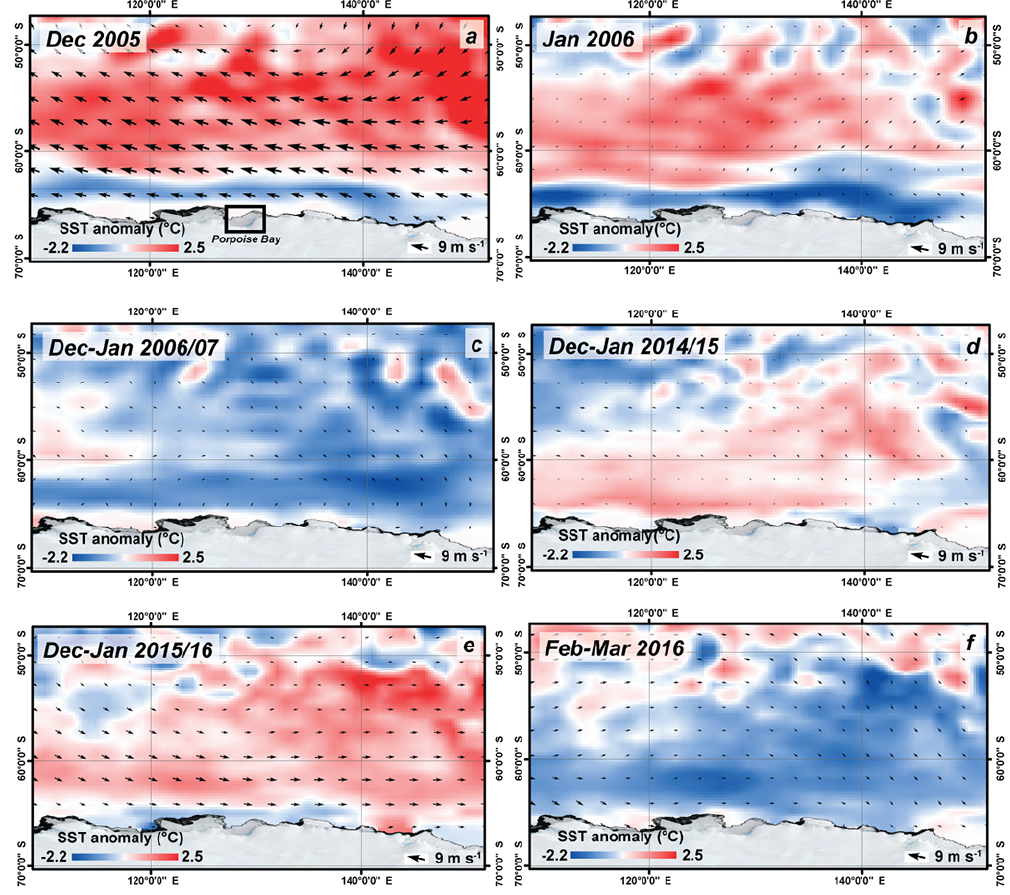
Figure 9. Mean monthly ERA-Interim derived wind-field and sea-surface temperature anomalies in the months preceding the 2007 and 2016 sea ice break-ups: (a) December 2005, (b) January 2006, (c) mean December and January 2006/2007, (d) mean December and January 2014/2015, (e) mean December and January 2015/2016, and (f) mean February and March 2016.